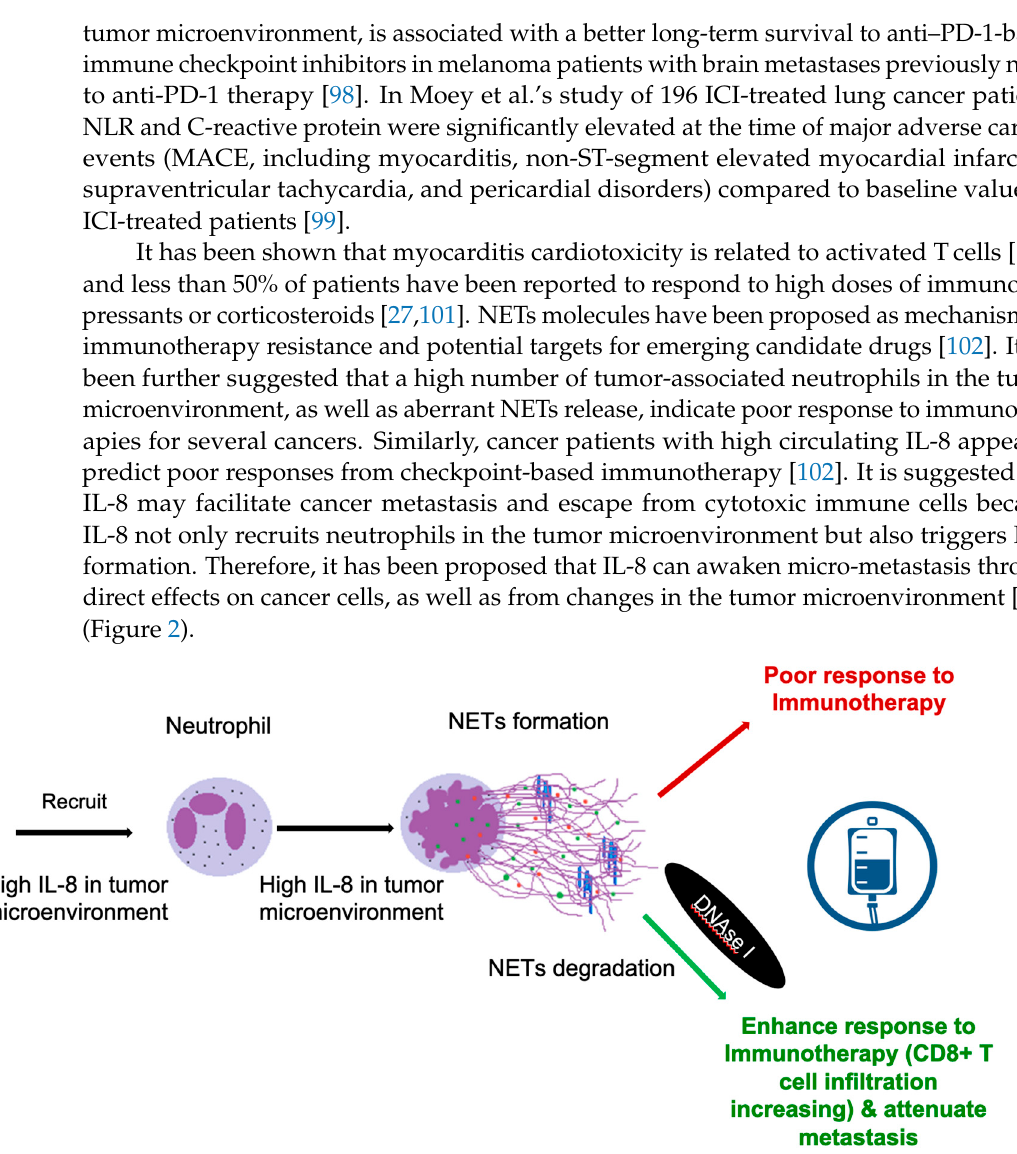
Figure 2. The high IL-8 in tumor environment recruits neutrophil and enhances NETs formation, which causes resistance to immunotherapy. DNase I reverses this situation. which causes resistance to immunotherapy. DNase I reverses this